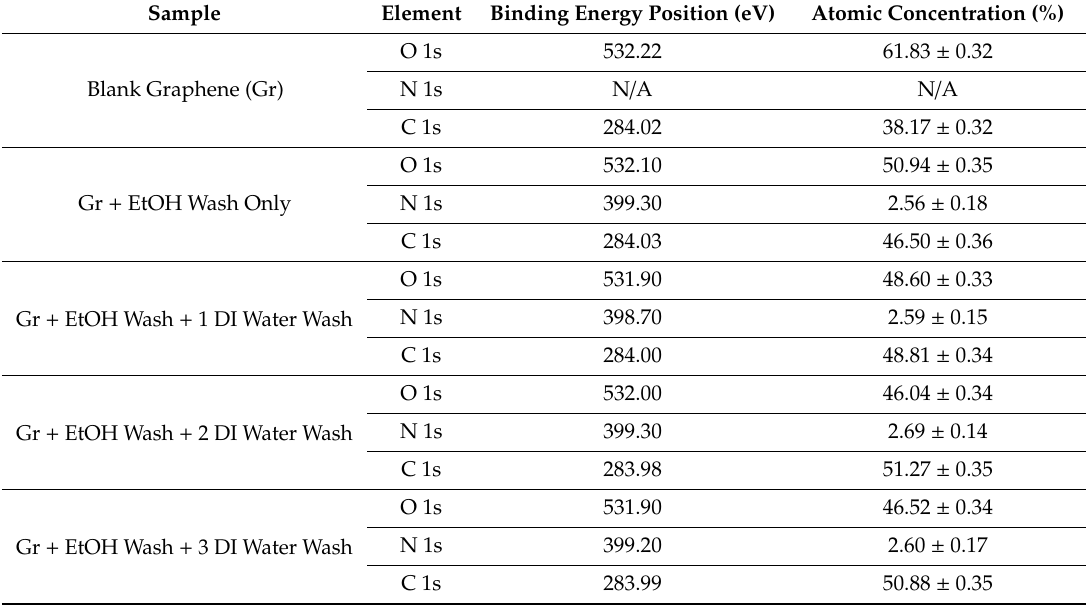
Table 2. The Atomic concentration of oxygen (O 1s), nitrogen (N 1s) and carbon (C 1s) via XPS for DAN modified graphene samples after multiple wash